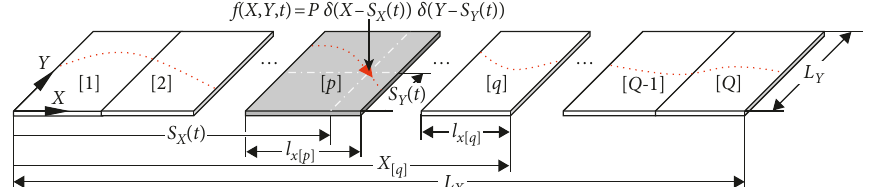
Figure 5: A multispan rectangular plate subjected to a moving point force P , where the red arrow indicates current position of the moving point